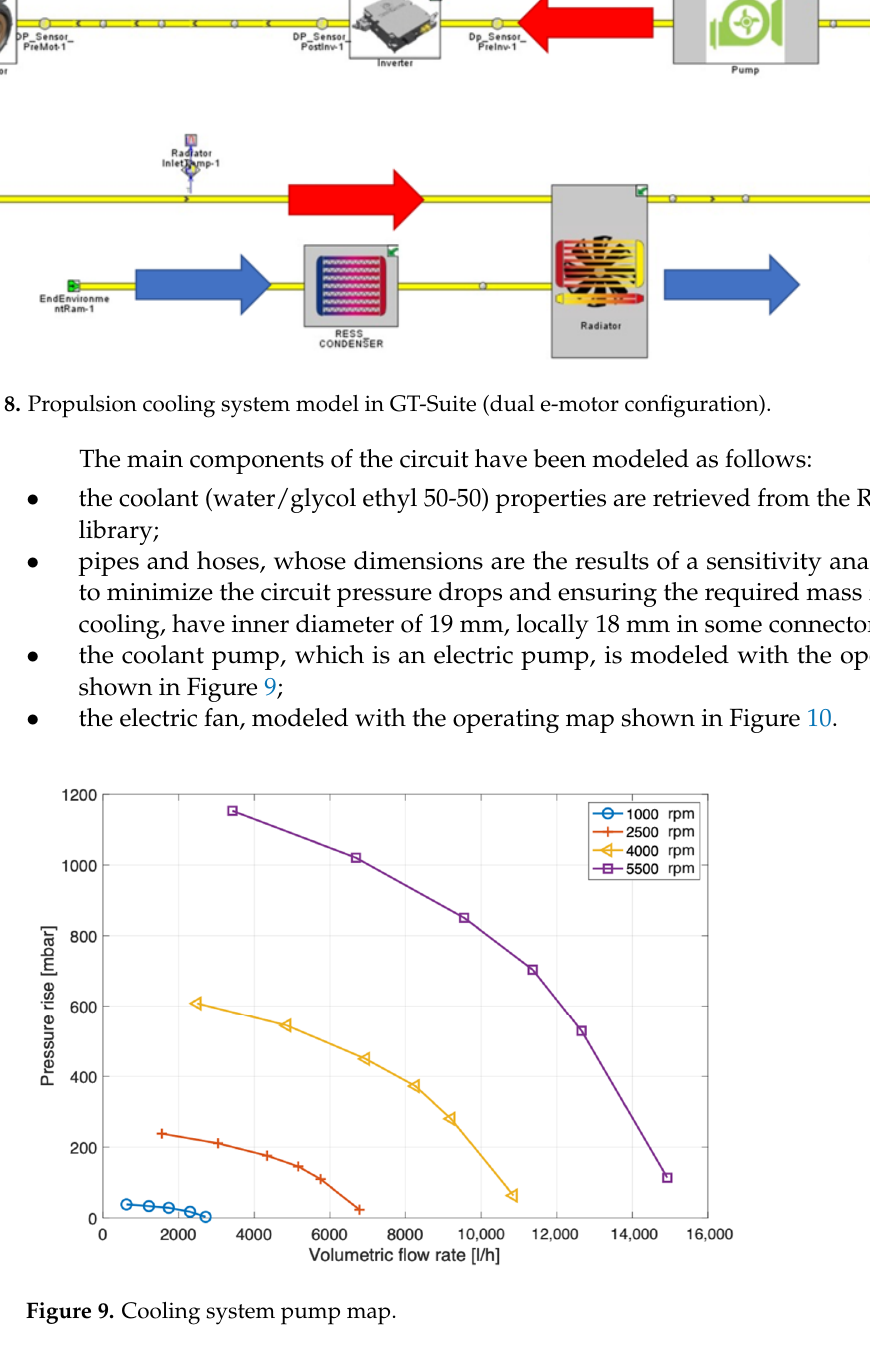
Figure 9. Cooling system pump map.